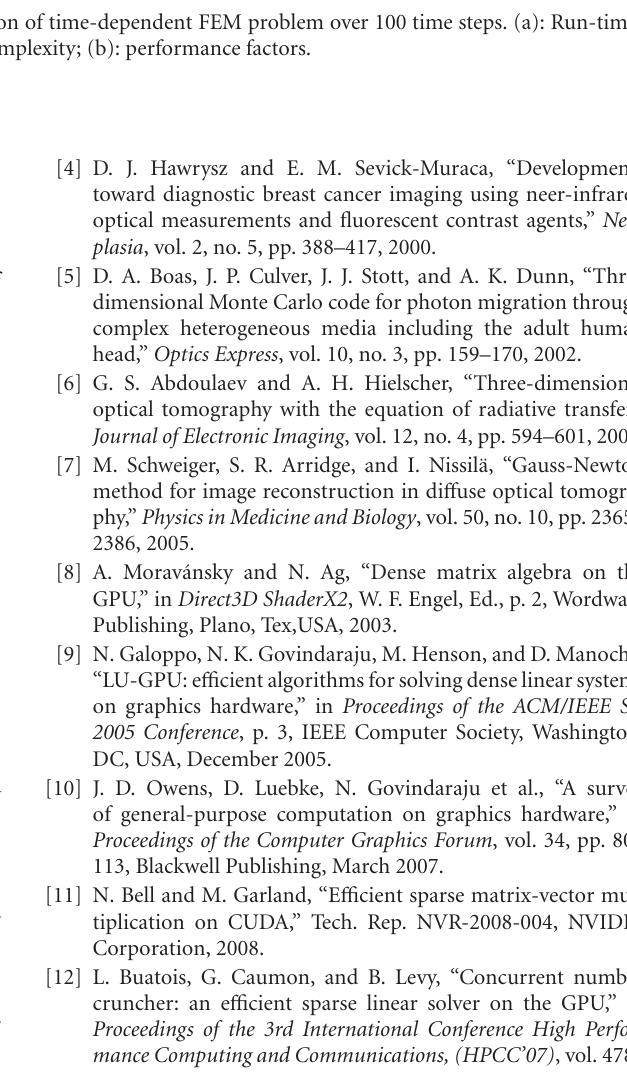
× 10 4 Number. of nodes